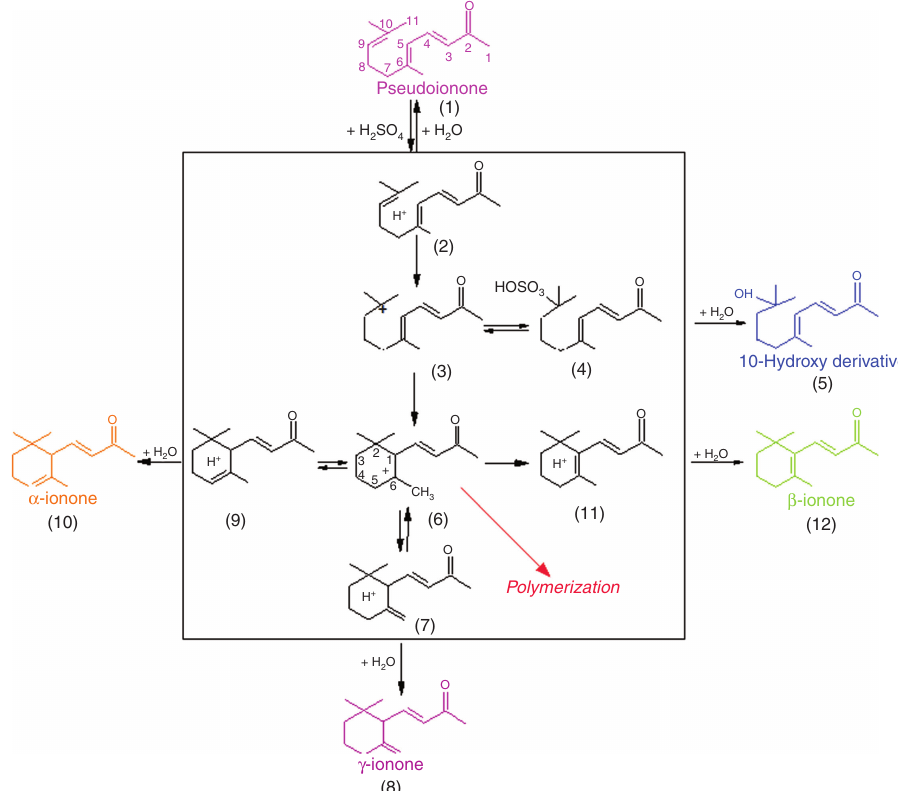
Figure 6 Reaction scheme of the cyclization of pseudoionone. Adapted from